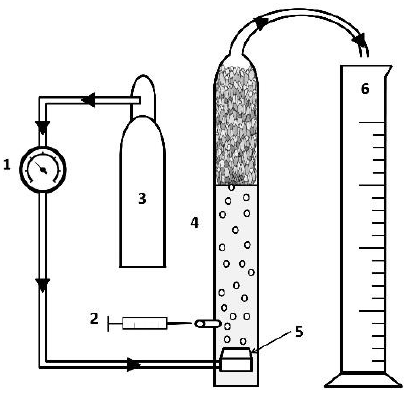
Figure 2. Experimental apparatus schematic diagram: 1. rotameter, 2. sample syringe and port, 3. compressed air cylinder, 4. flotation column, 5. gas dispersion frit, 6. foamate reservoir.